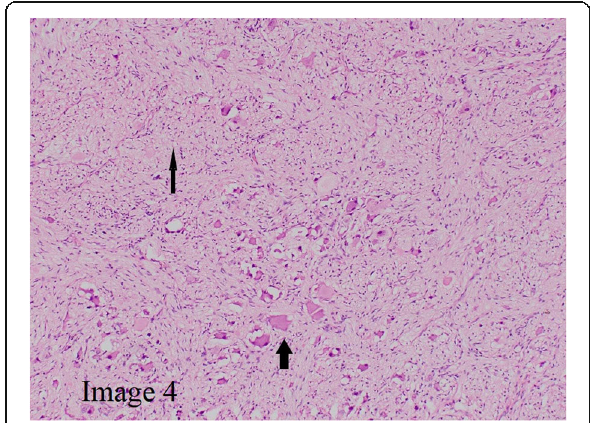
Fig. 4 Hematoxylin and eosin stain showing ganglioneuroma with mature ganglion cells and Schwannian rich stroma (thick arrow indicates a mature ganglion cell, and thin arrow indicates the schwannian rich stroma)